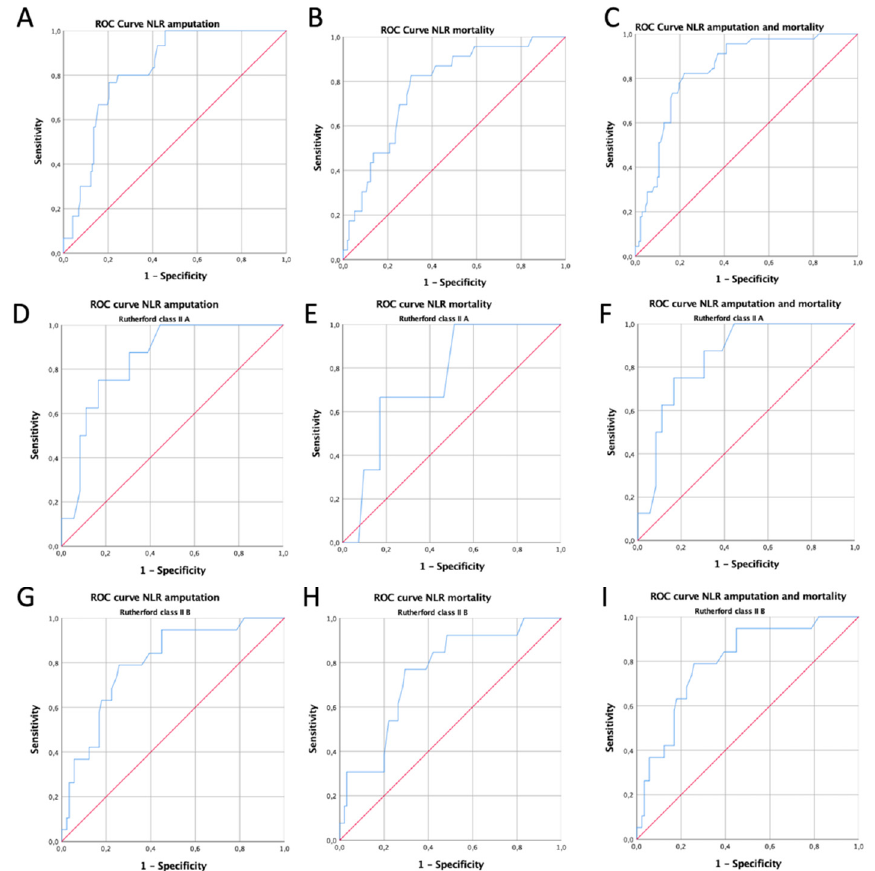
Figure 2. ROC curve analysis ( A ) for NLR with respect to amputation rate in all patients (c-statistic 0.823), ( B ) for NLR with respect to mortality in all patients (c-statistic 0.776), ( C ) for NLR with respect to amputation + mortality rate in all patients (c-statistic 0.840), ( D ) for NLR with respect to amputation rate in RC IIA patients (c-statistic 0.845), ( E ) for NLR with respect to mortality in RC IIA patients (c-statistic 0.752), ( F ) for NLR with respect to amputation + mortality rate in RC IIA patients (c-statistic 0.845), ( G ) for NLR with respect to amputation rate in RC IIB patients (c-statistic 0.798), ( H ), for NLR with respect to mortality in RC IIB patients (c-statistic 0.751), and ( I ) for NLR with respect to amputation + mortality rate in RC IIB patients (c-statistic 0.798).; ROC: receiver-operating characteristic; NLR: neutrophil-to-lymphocyte ratio; RC: Rutherford